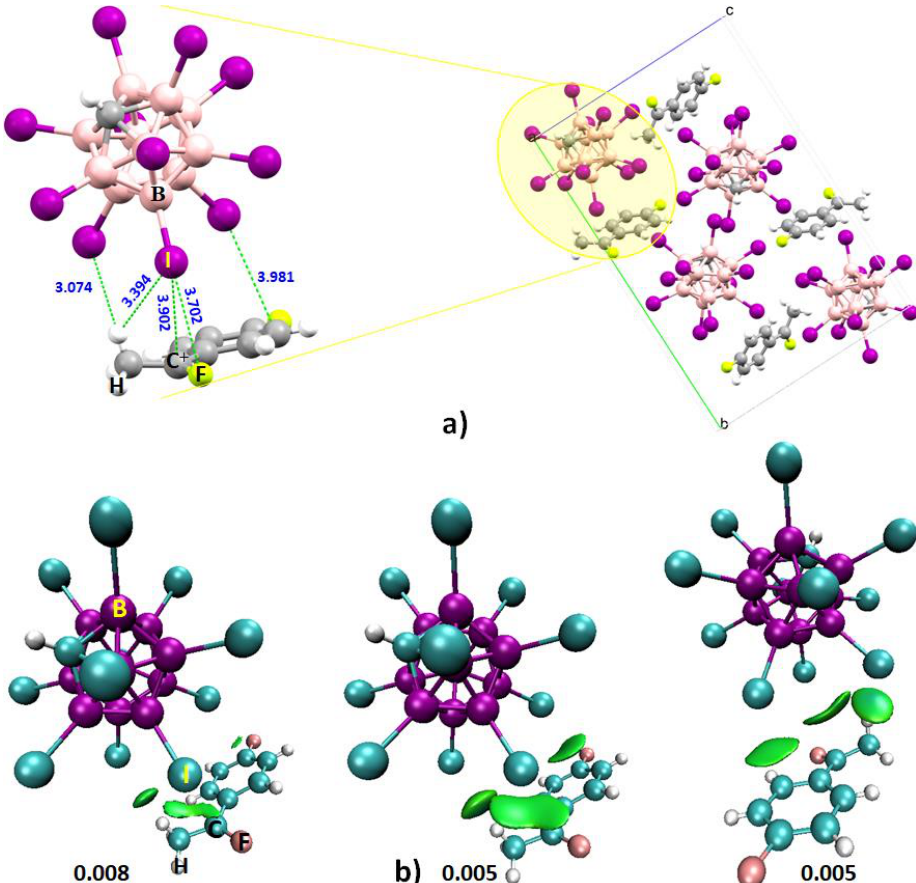
Figure 17. ( a ) The unit cell (right) of the crystal structure of 1-fluoro-1-(4-fluorophenyl)ethylium 1-carba-2,3,4,5,6,7,8,9,10,11,12-undecaiodododecaborate (CSD ref. DEZDIW). ( b ) The IGM isosurface plot, obtained with two different isovalues: 0.0080 and 0.0050 a.u. Intermolecular distances are shown in ( a ) are in